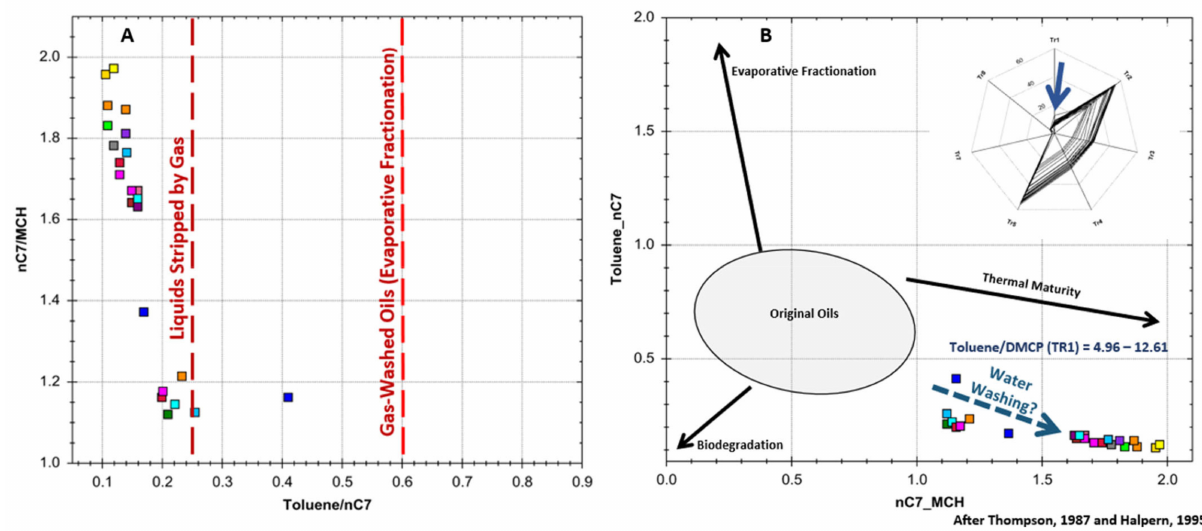
Figure 16. ( A ) Thompson [55] plot showing increasing evaporative fractionation (gas washing) can cause the residual liquid to be heavier and more aromatic (down and to the right) but the migrating gas will become more liquid rich (up and to the left). Here most of the Marcellus liquids appear to have been stripped by gas (dry gas picks up light hydrocarbons, i.e., the gas dissolves light end alkanes into itself [54]). ( B ) Halpern [59] interpretive plot shows low toluene/nC 7 and systematically increasing nC 7 /MCH trends suggestive of water washing. This interpretation is supported by low toluene/DMCP (TR1 on the insert star plot), and very low amounts of benzene. Very low TR7 suggest migration and secondary alteration effects